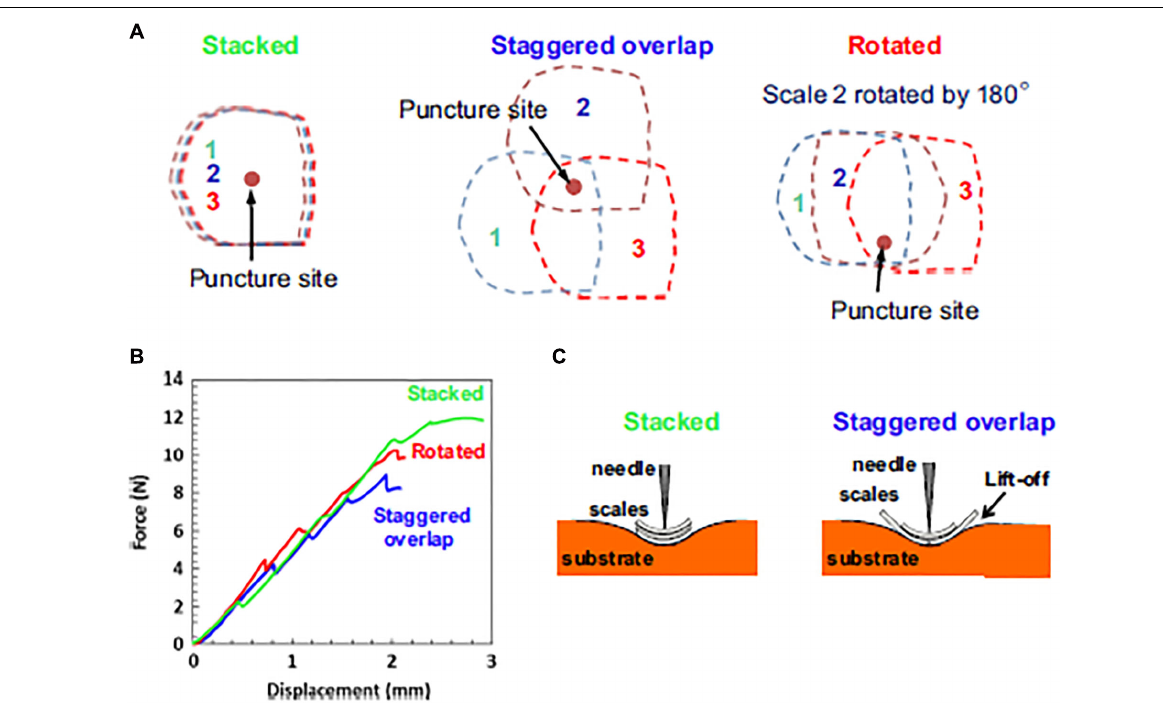
Frontiers in Materials |